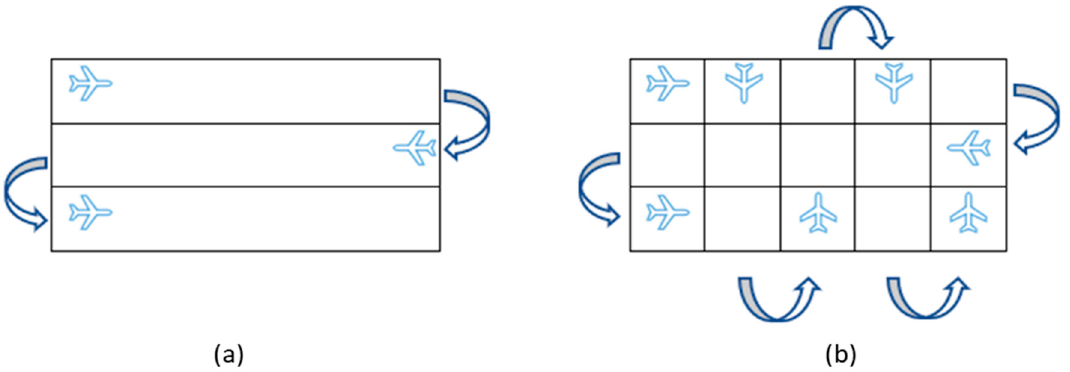
Figure 1. The pathways of aerial bait distribution in parallel flights ( a ) and in crisscross flights ( b ).